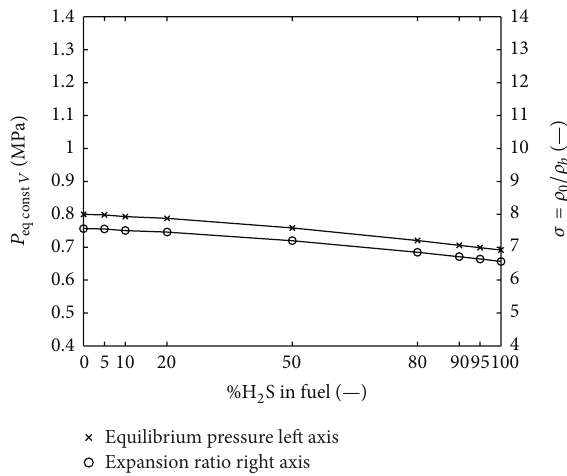
Equilibrium pressure left axis Expansion ratio right axis Figure 1: Cantera calculation. Constant volume combustion equi- librium pressure for stoichiometric fuel ranging from pure NG (left) to pure H 2 S (right).